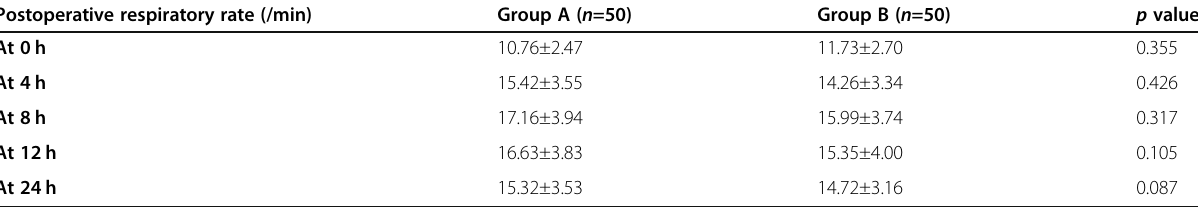
Table 4 Difference between group A and group B according to postoperative respiratory rate